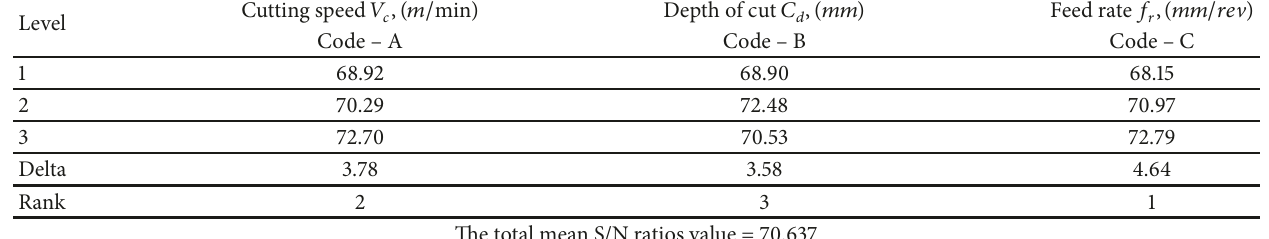
Table 6: Response table of mean signal to noise ratios.